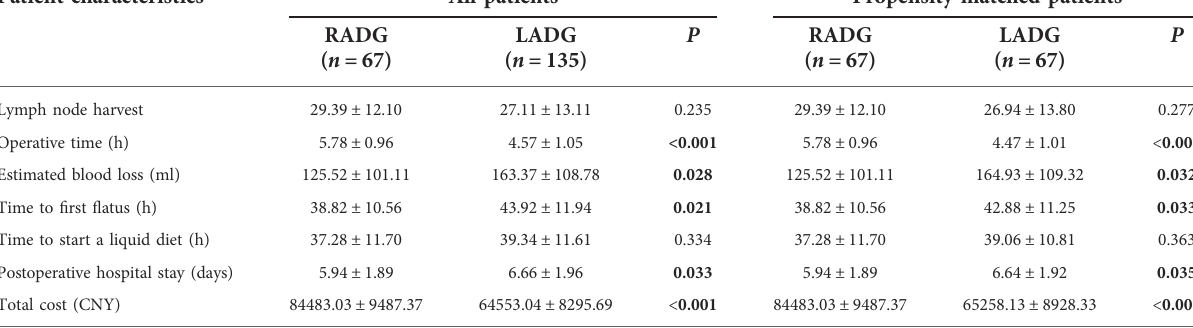
TABLE 3 Perioperative and short-term oncologic outcomes between the RADG and LADG groups. Patient